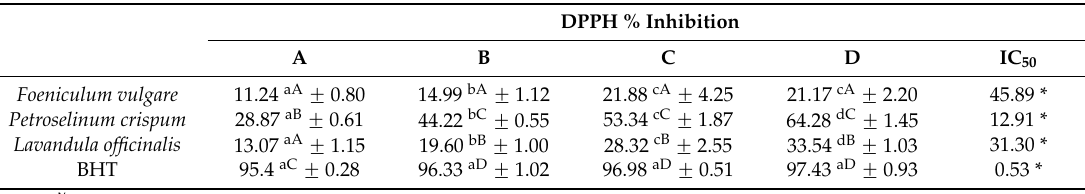
Table 3. Antioxidant activity of organic fennel, parsley, and lavender essential oils from Spain using the corresponding concentrations (A = 5 g/L, B = 10 g/L, C = 20 g/L, D = 50 g/L) measured by DPPH method.